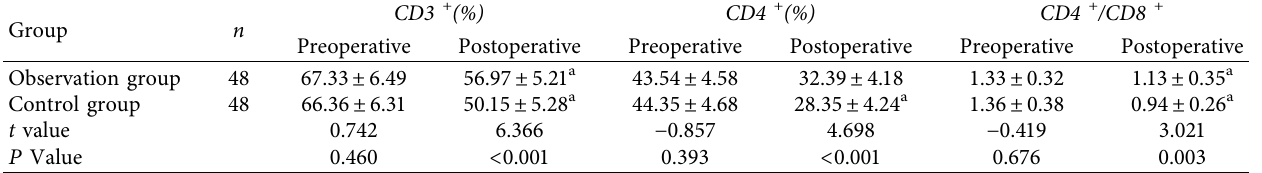
Table 3: Comparison of immune function indexes between the two groups before and after surgery ( x ± s ).